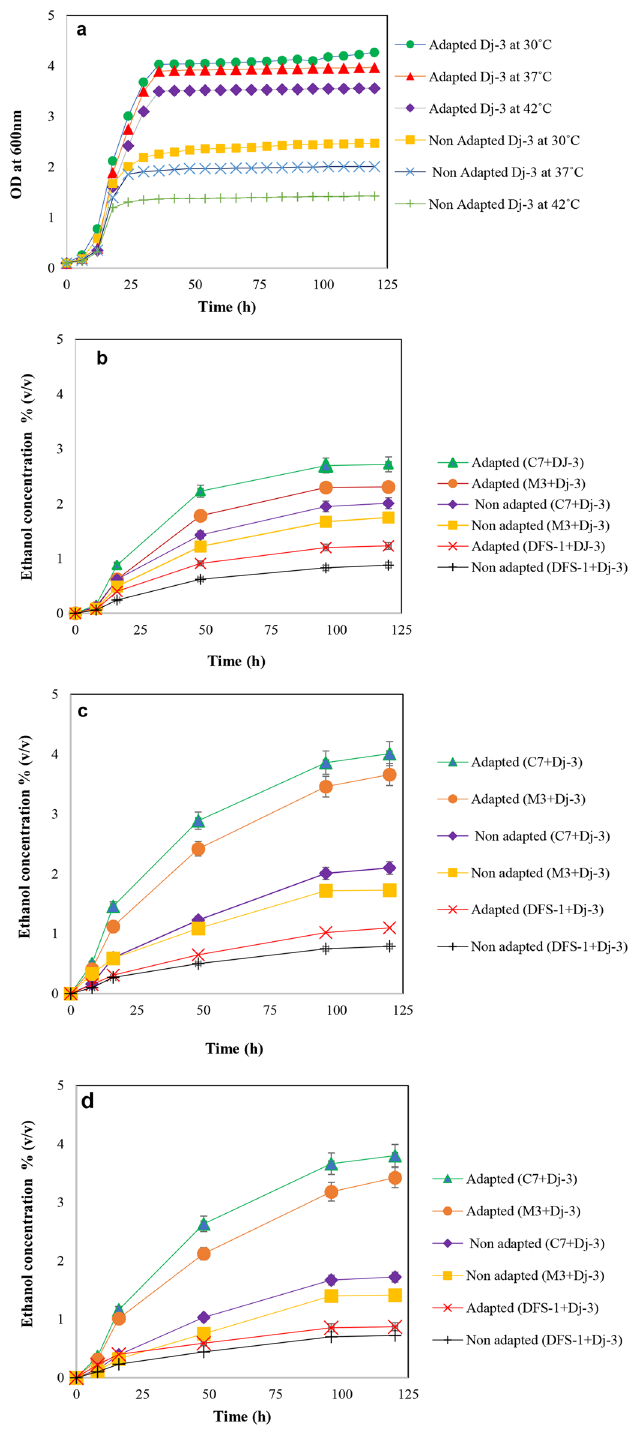
Figure 5. Improvement of ethanol production capability (%) of adapted strains through co-culturing with adapted thermotolerant Dj-3 ( Saccharomyces cerevisiae ). Here ( a ) represents growth pattern of Dj-3 at 30 °C, 37 °C and 42 °C, before and after temperature adaptation in YPD medium, where ( b – d ) represents the ethanol production capability of adapted starch fermenting strains with adapted Dj-3 strains in co-culture conditions at 30 °C, 37 °C and 42 °C respectively. Co-culture process, experimental procedures and conditions have been explained in the “Methods”